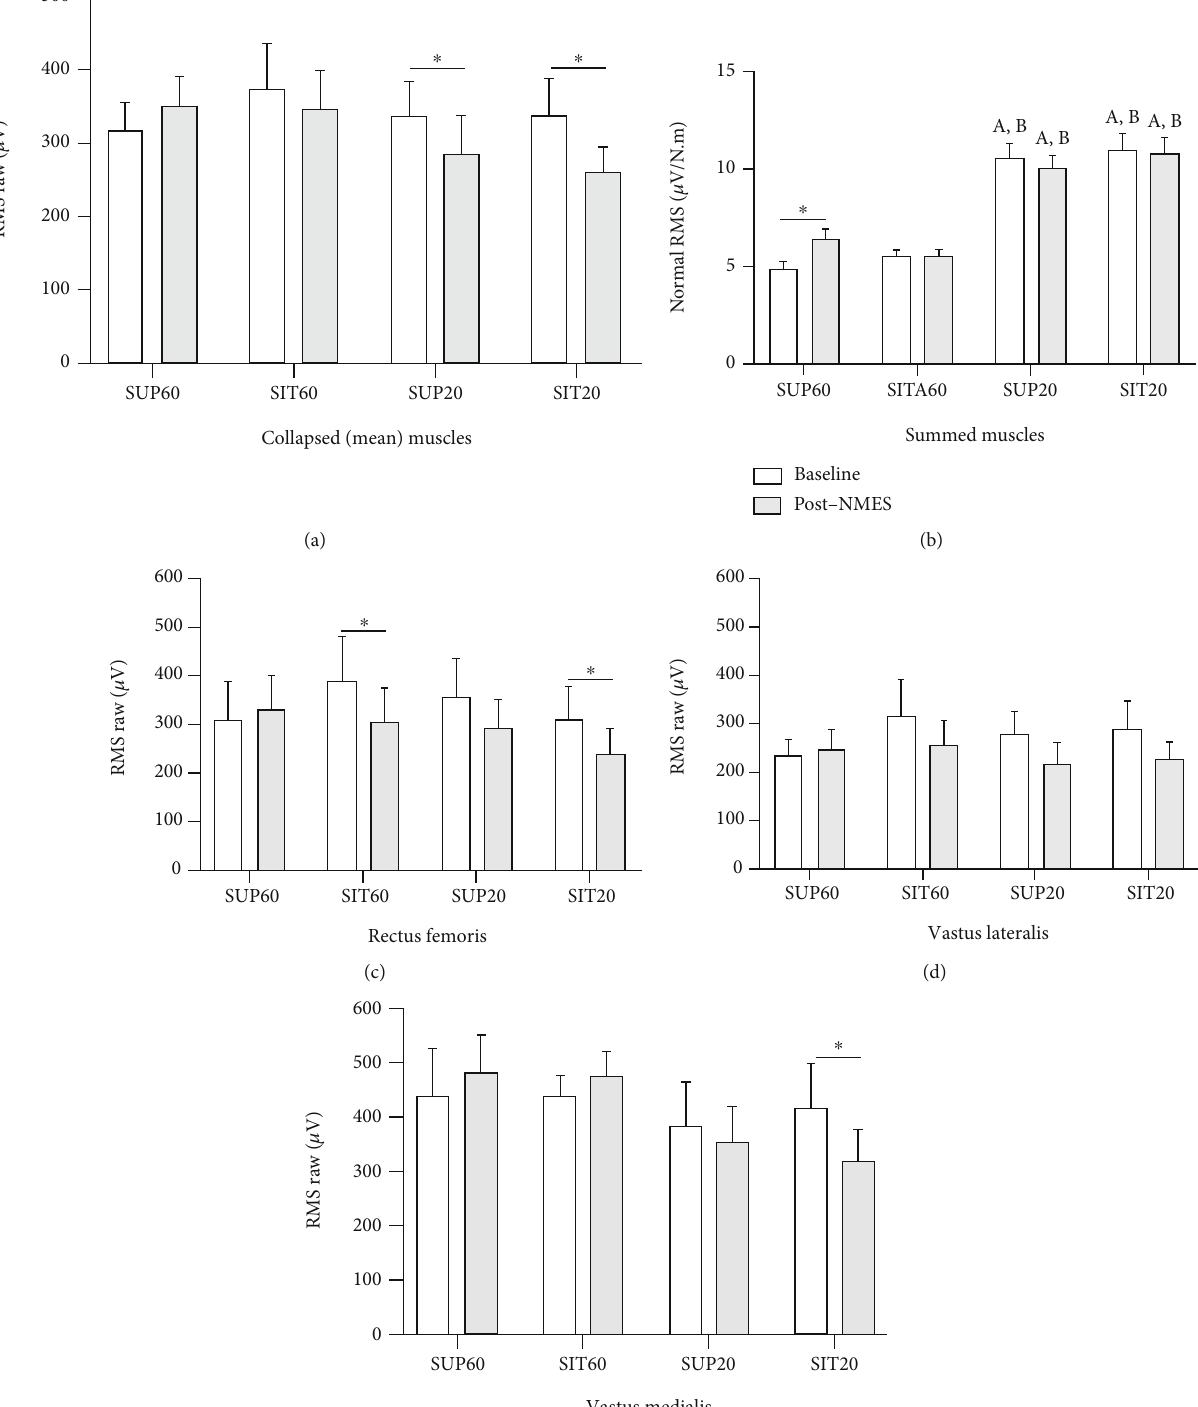
Figure 3: Raw and normalized root mean square (RMS) pre- (baseline) and post-NMES for quadriceps constituents individually and grouped. Data are presented as mean and 95% CI. Abbreviations: SUP60: supine with knee fl exed at 60 ° ; SIT60: seated with knee fl exed at 60 ° ; SUP20: supine with knee fl exed at 20 ° ; SIT20: seated with knee fl exed at 20 ° . NMES: neuromuscular electrical stimulation. Statistically signi fi cant di ff erences: ∗ p < 0 : 05 vs. baseline; a p < 0 : 05 vs. SUP60; b p < 0 : 05 vs.